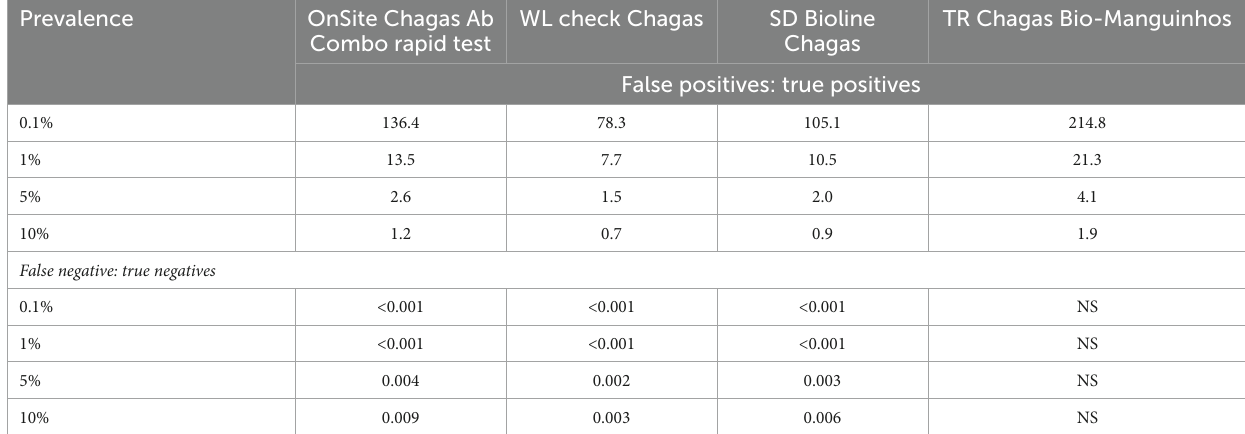
TABLE 2 Chance of false positive in relation to true positives and of false negatives in relation to true negatives for different prevalence values of chronic Chagas disease.